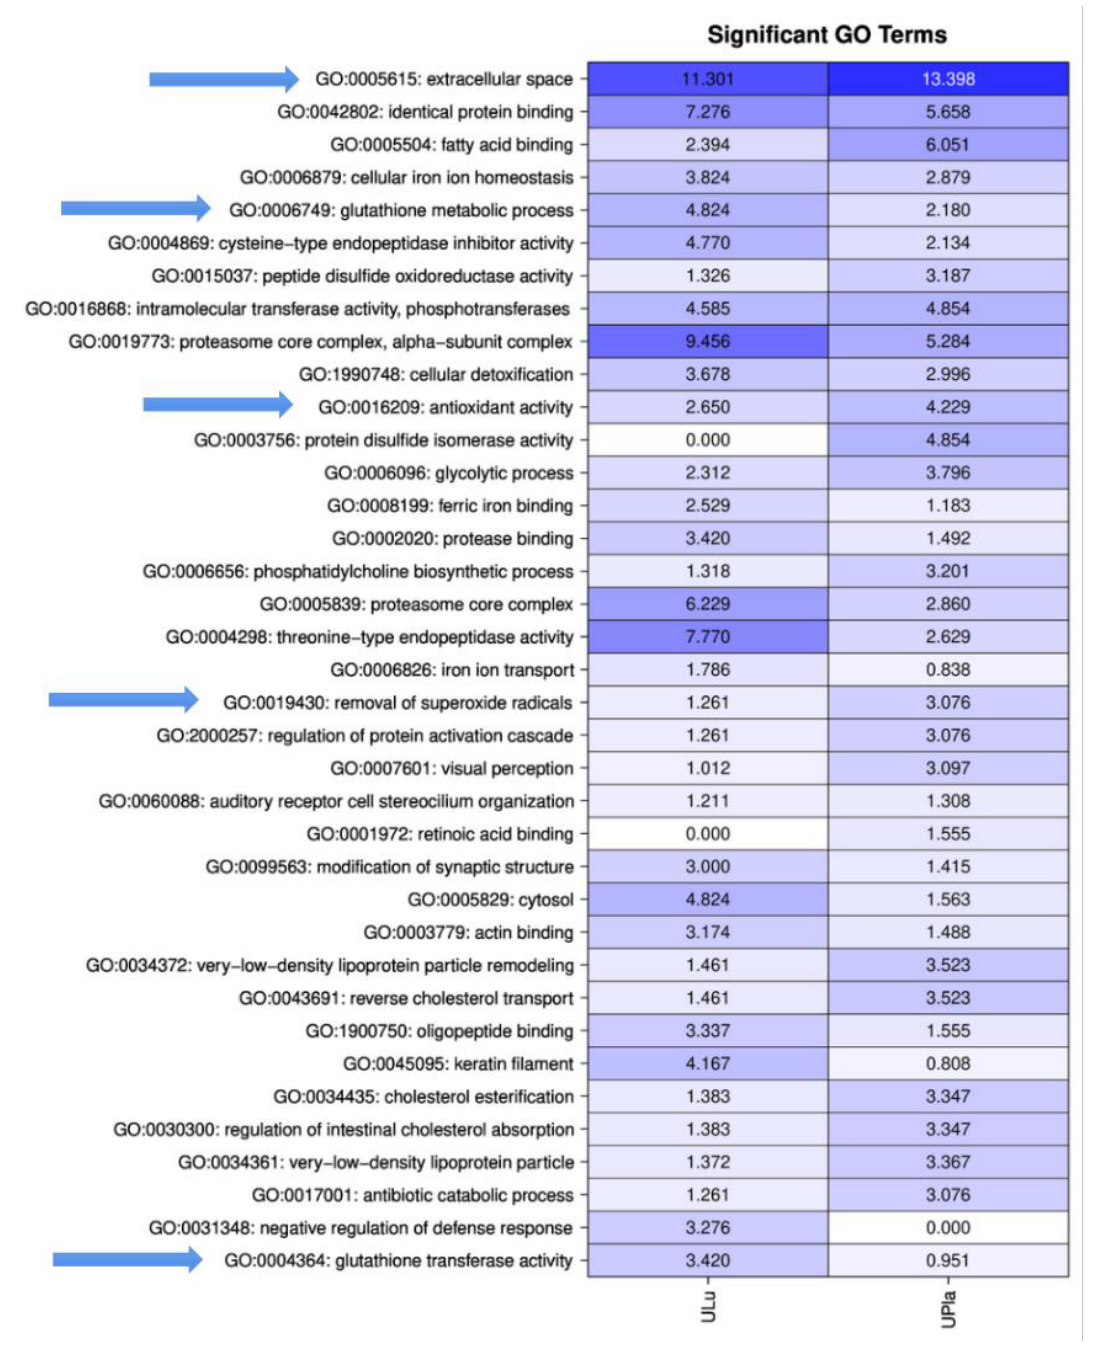
Figure 2. Matrix with − log 10 p -values of significantly identified GO terms for ULu and UPla. Columns indicate the different tissues; rows indicate the GO terms. All GO terms with a p -value < 0.001 were used. Values > 1.3 are significant. Arrows mark important GO terms related to oxidative stress and